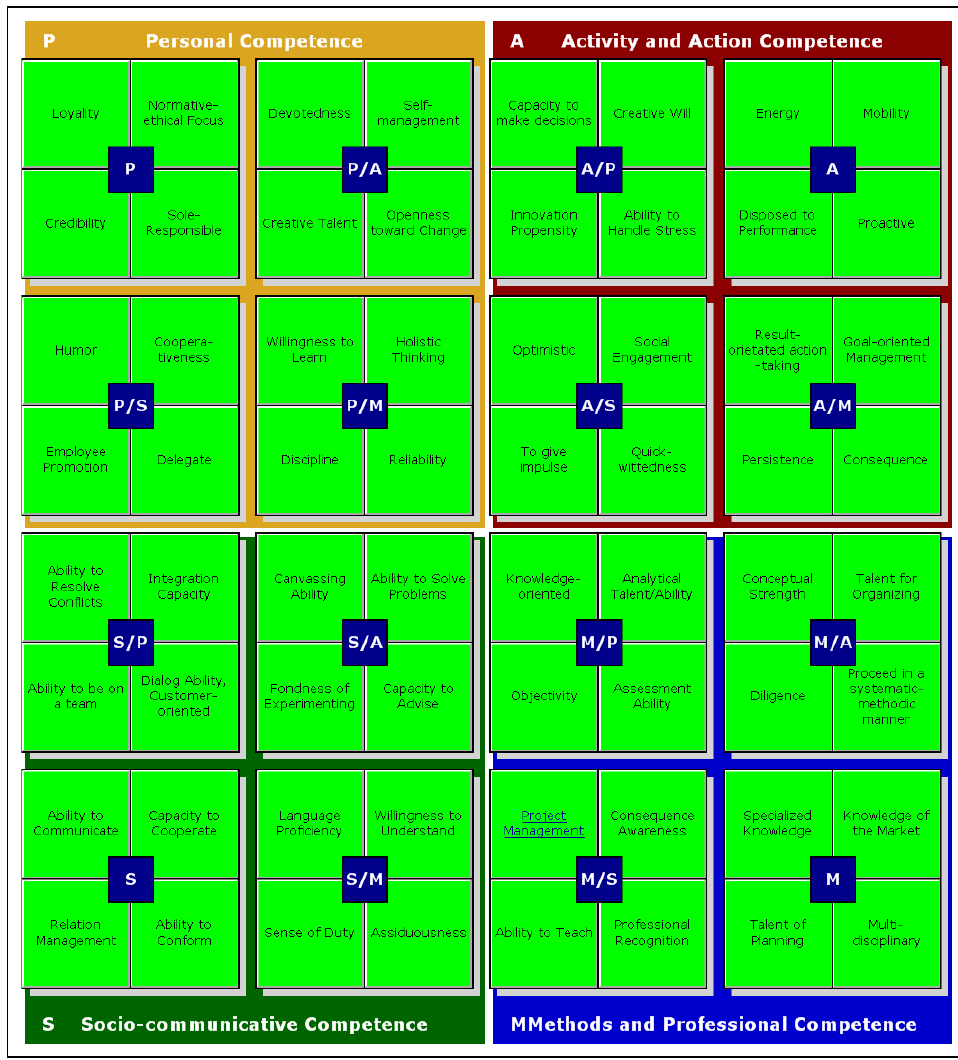
Figure 2 . The competence explorer (Heyse & Erpenbeck, 2004, p. XXI). Cross-sectional competencies are complex competencies whose facets influence all four competence classes. Examples of cross-sectional competencies are media competence, management or leadership competence, innovation competence, and intercultural competence (see Zawacki-Richter & Hasebrook, 2005). In this context, cross-sectional competencies are also referred to as meta-competencies (Weinert,